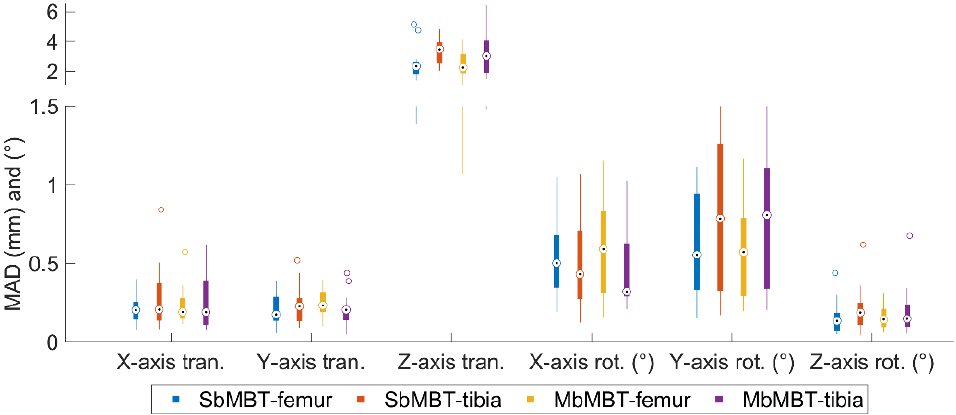
Figure 6. Boxplot of the mean absolute differences (MADs) of six pose parameters of the femur and tibia-fibula determined using single-body model-based tracking (SbMBT) and multibody model- based tracking (MbMBT). The central marks indicate the median values. The top and bottom sides of the solid box represent the 75th and 25th percentiles of the MAD distribution, respectively. The whiskers indicate the extreme values, and the outliers are drawn with hollow